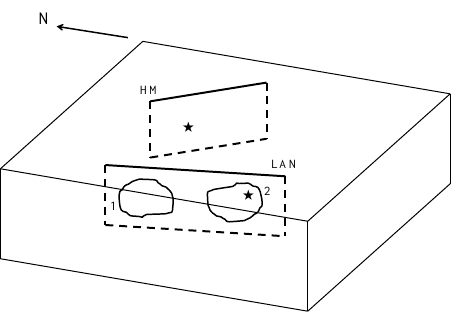
Figure 6. Geometry of the Landers (LAN) and Hector Mine (HM), California, faults that generated the 1992 and 1999 earthquakes, re- spectively. The stars indicate the hypocentres of the seismic events. The labels 1 and 2 identify the asperities on the Landers